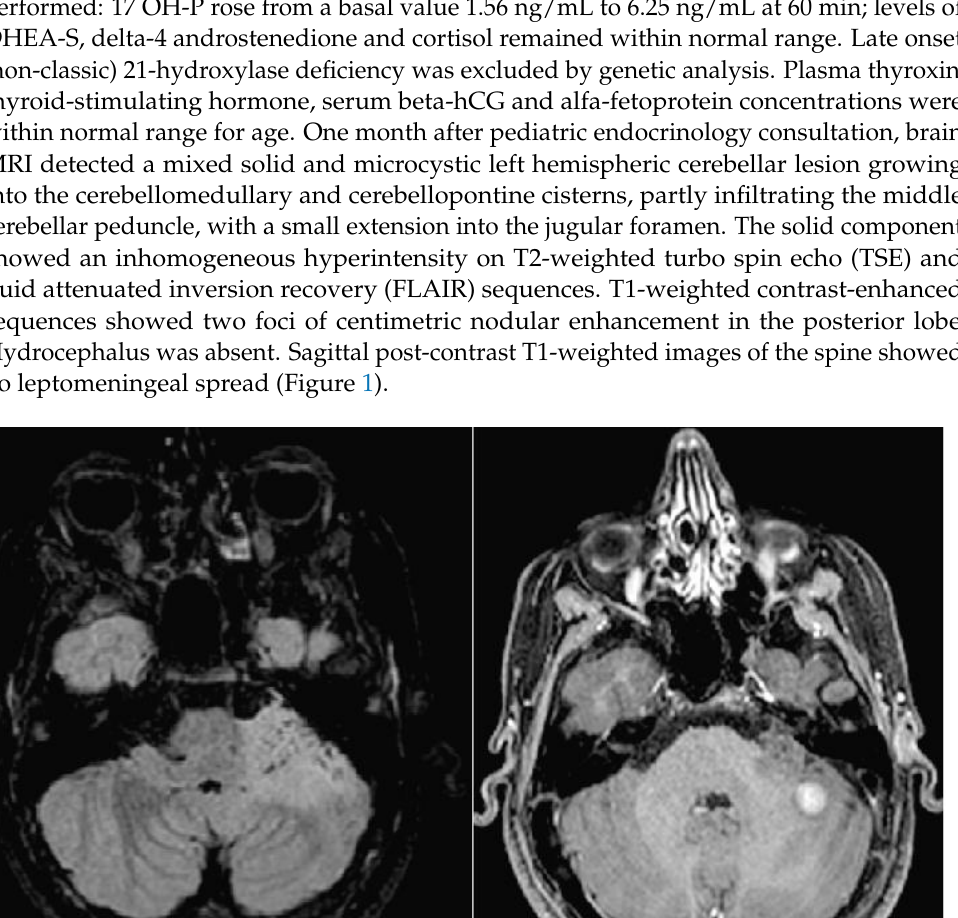
Figure 2. Postoperative brain MR images. A residual infiltration in the upper portion of the middle cerebellar peduncle is evident in axial FLAIR T2 weighted images ( A ). No residual contrast enhance- ment is evident after gadolinium administration in T1 weighted images ( B ).